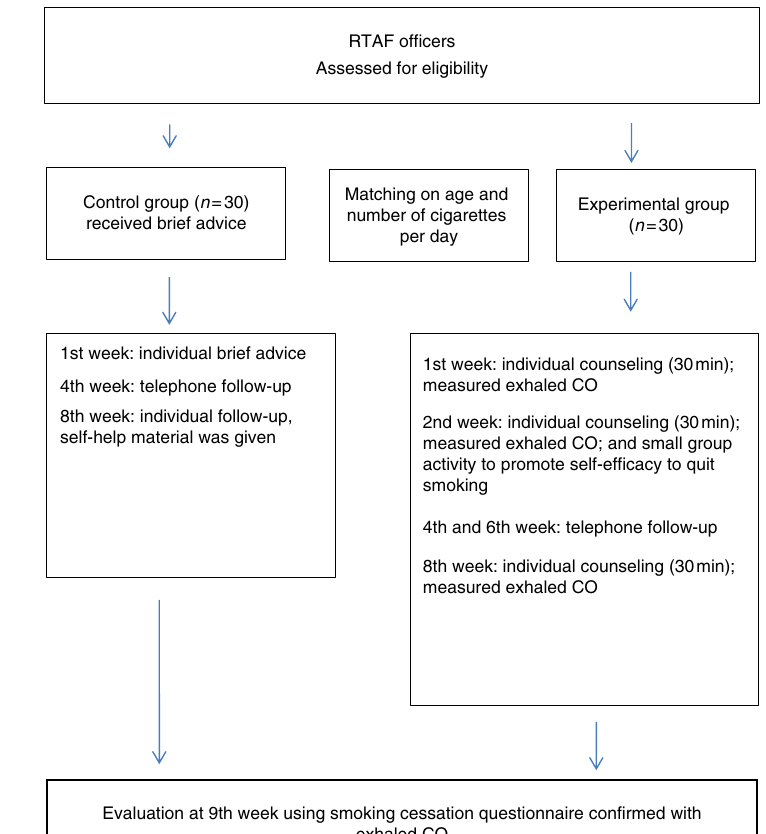
Figure 1. Scheme of the motivation to quit smoking